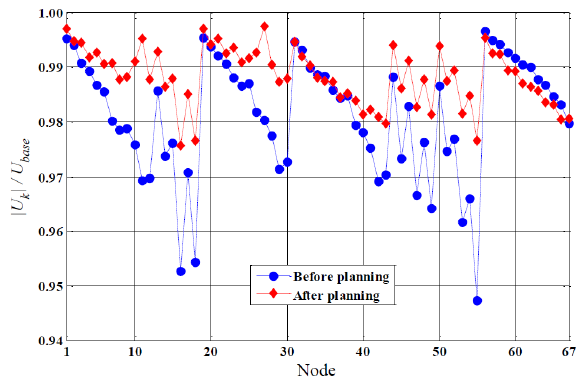
Fig. 5 Comparison curve before and after node voltage